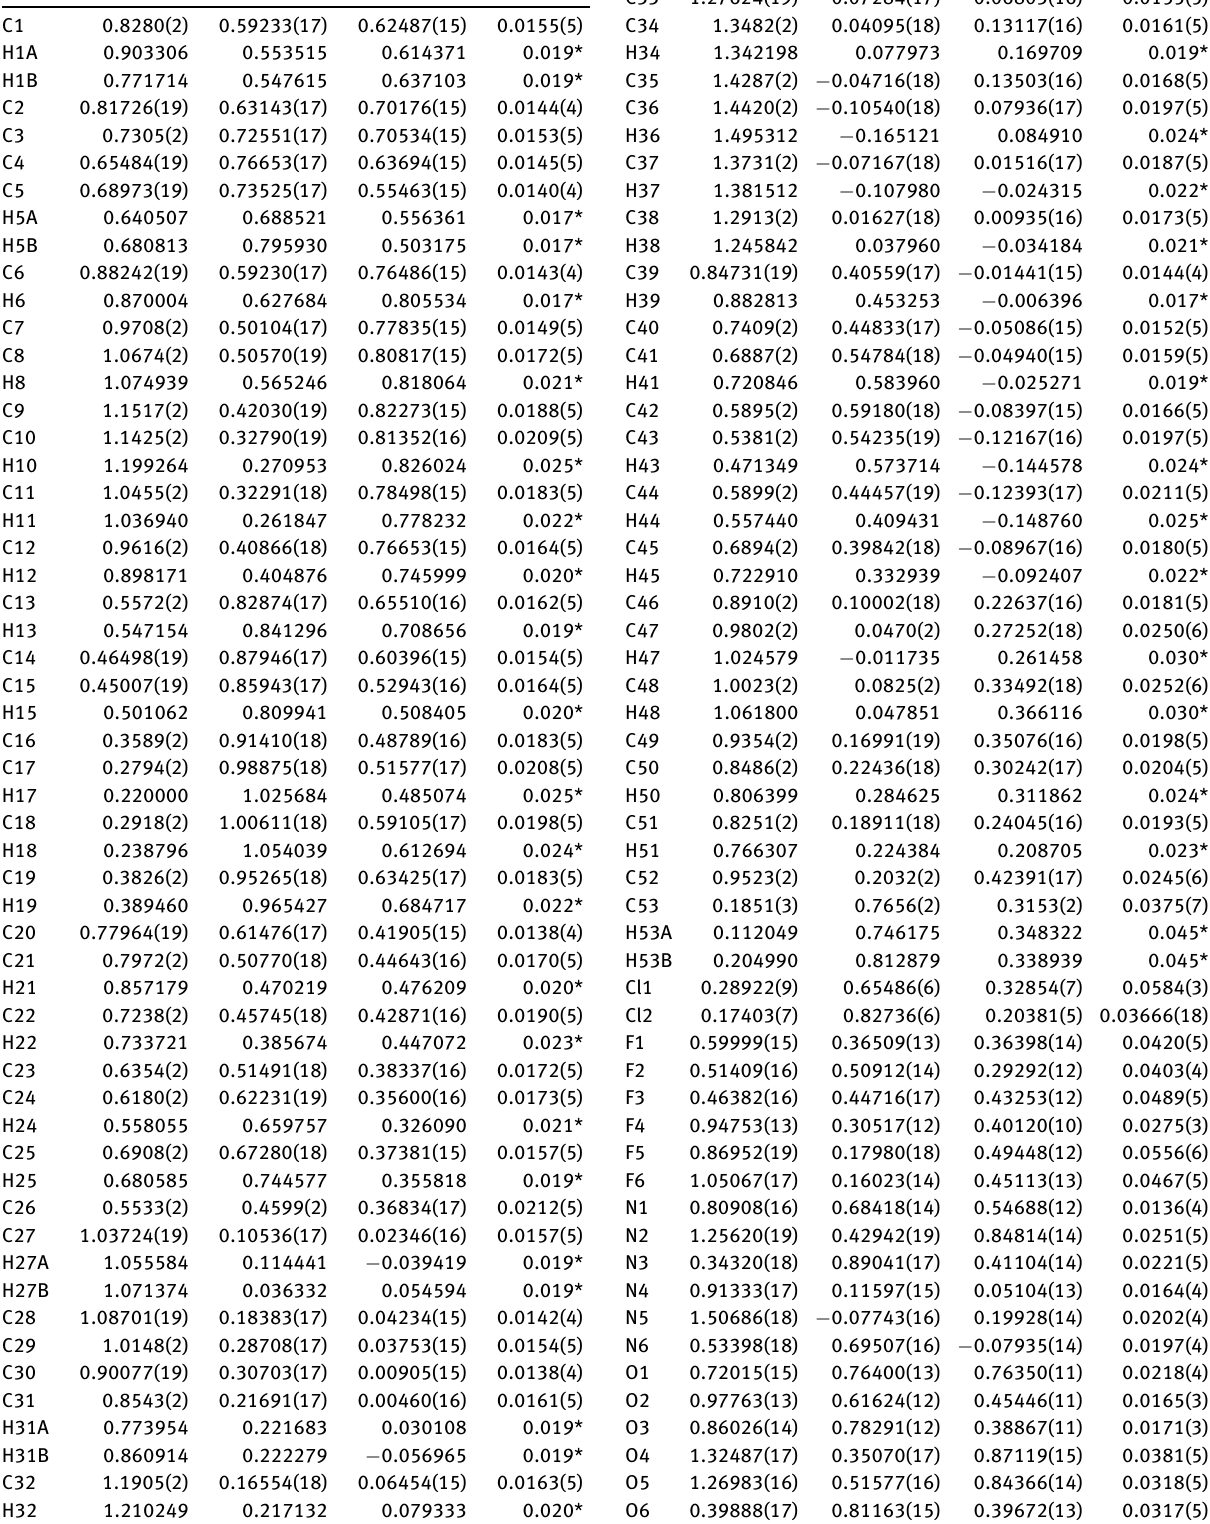
Table 2: Fractional atomic coordinates and isotropic or equivalent isotropic displacement parameters (Å 2